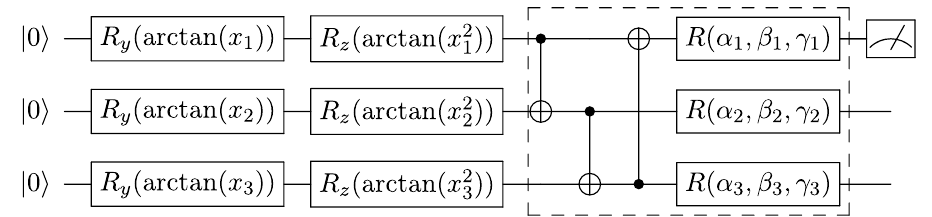
Figure 1. Variational quantum circuit component. The single-qubit gates R y ( arctan ( x i )) and R z ( arctan ( x 2 i )) represent rotations along the y - and z -axis by the given angle arctan ( x i ) and arctan ( x 2 i ) , respectively. Arctan is used because the input values are not in the interval of [− 1, 1 ] . The CNOT gates are used to entangle quantum states from each qubit and R (α , β , γ) represents the general single qubit unitary gate with three parameters. The parameters labeled R y ( arctan ( x i )) and R y ( arctan ( x 2 i )) are for state preparation and are not subject to iterative optimization. Parameters labeled α i , β i and γ i are optimized iteratively. The dashed box denotes one layer of a quantum subcircuit. The dial to the far right represents that the circuit has one output that is the σ z measurement of the first